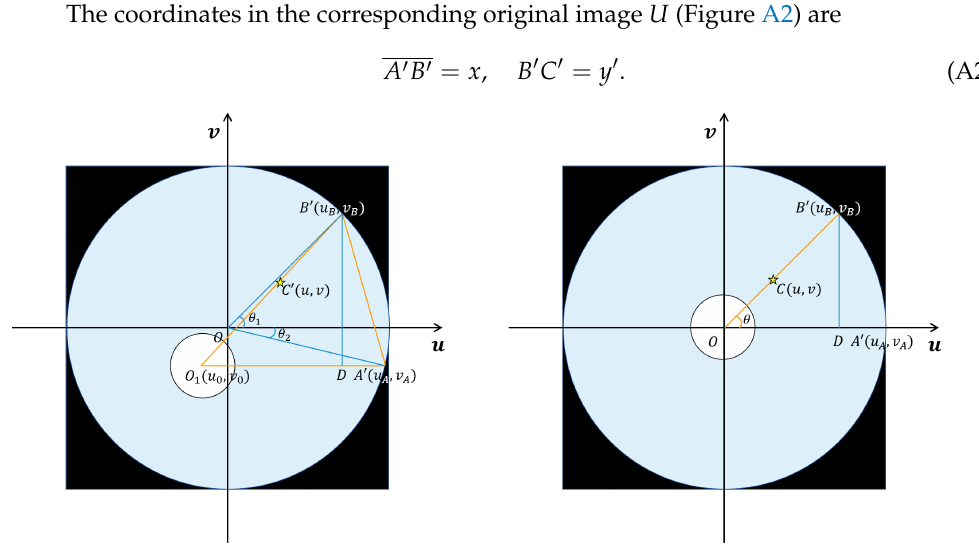
Figure A1. Original image